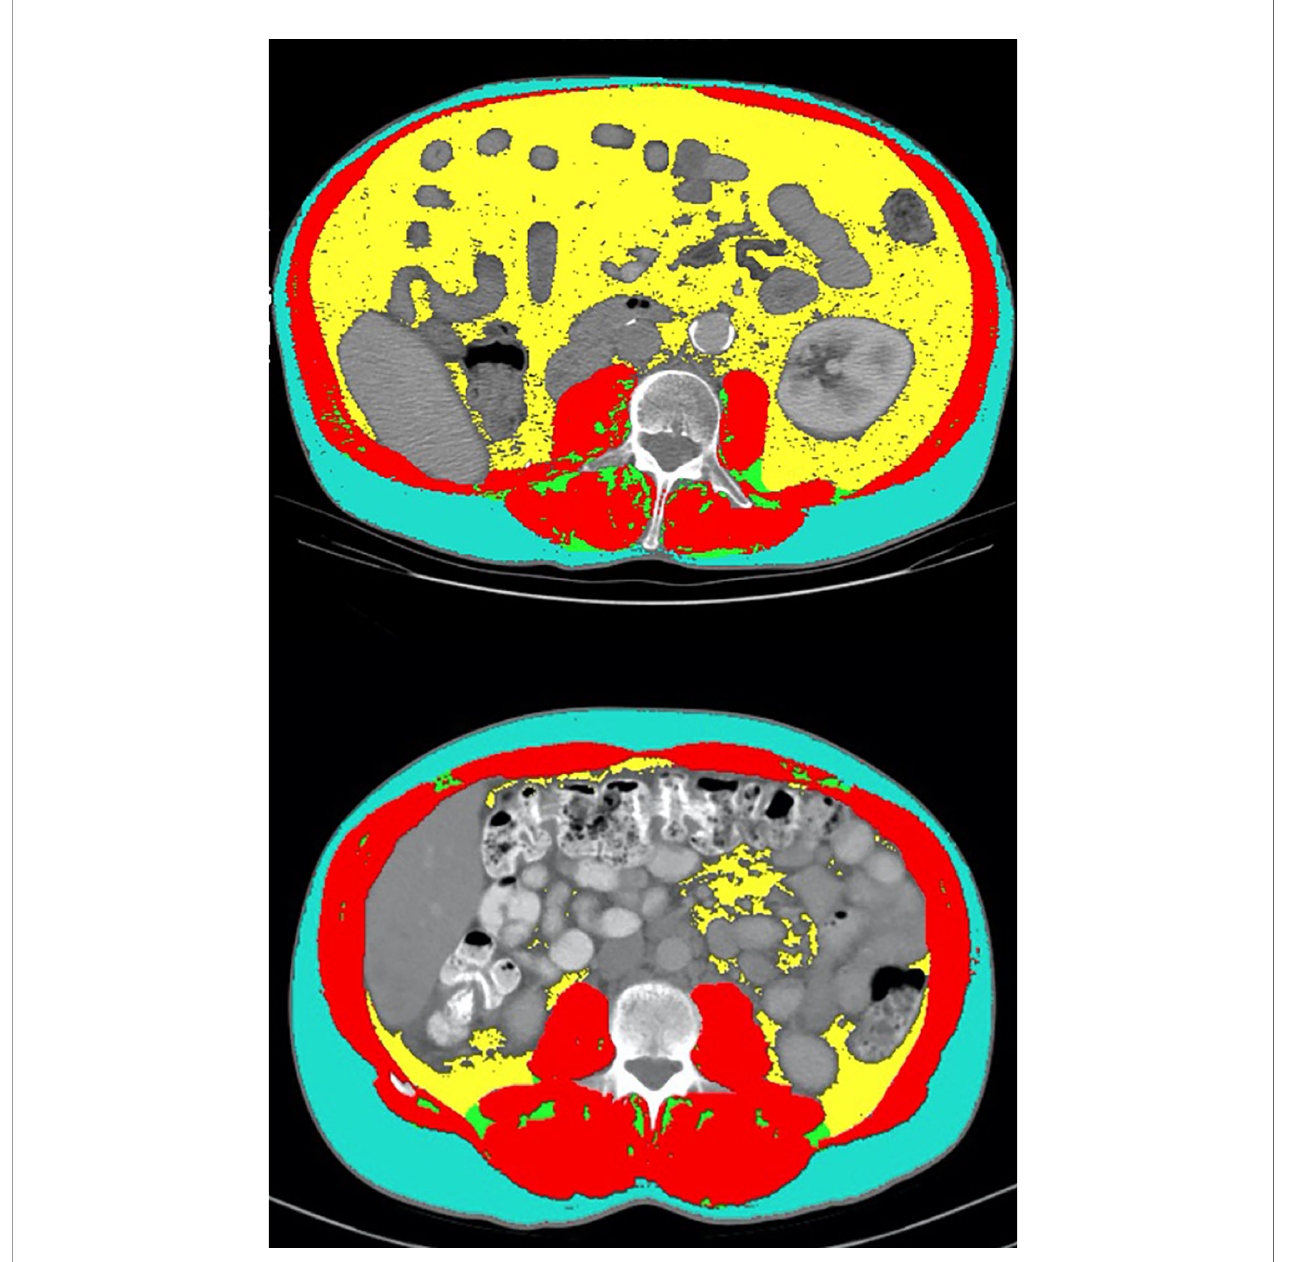
FIGURE 3 | Comparison of select CT segmentation results between two patients with similar BMI but disparate TFI and clinical outcomes. The fi rst patient (top panel) had a BMI of 24.9 and a TFI of 119.97 (high). He had a best radiographic response of partial response on treatment with anti-PD-1 combination therapy. The second patient (bottom panel) had a BMI of 24.4, but a TFI of 44.88 (low). This patient had a best radiographic response of progressive disease on treatment with anti-PD-1 combination